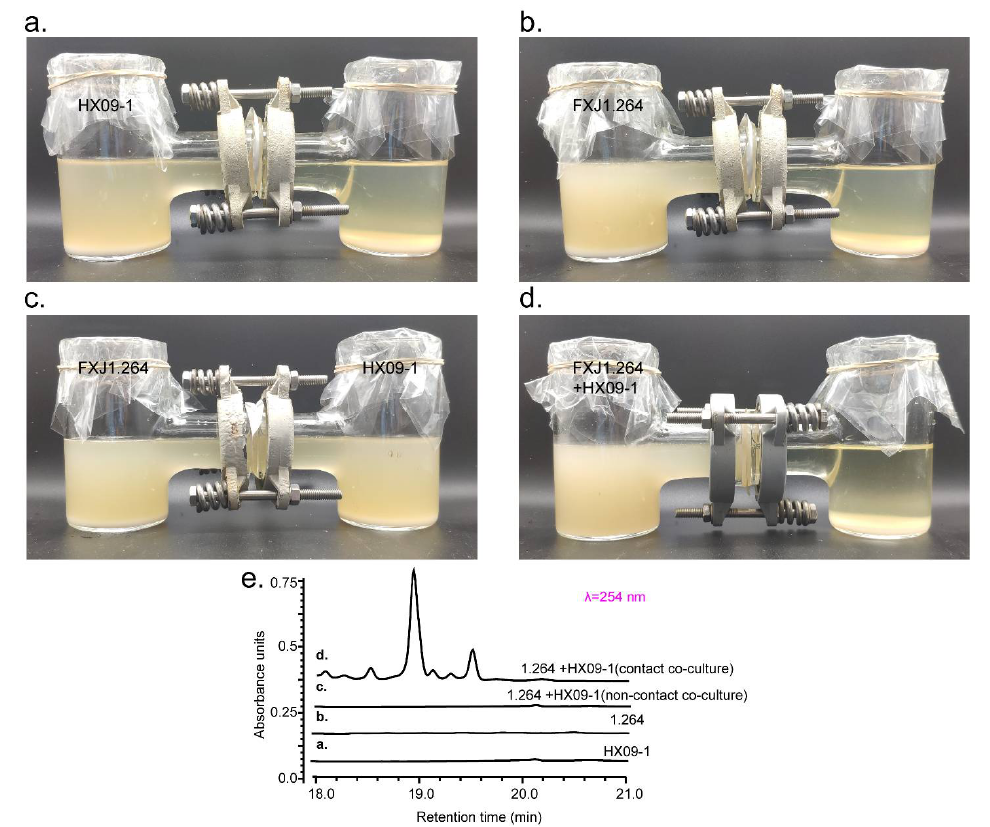
Figure 4. Contact and non-contact co-cultures of S . sp. FXJ1.264 and M . sp. HX09-1 and related HPLC profiling. ( a ) S . sp. FXJ1.264 was only inoculated in the left compartment; ( b ) M . sp. HX09-1 was only inoculated in the left compartment; ( c ) S . sp. FXJ1.264 and M . sp. HX09-1 were individually inoculated in the left and right compartment, respectively; ( d ) S . sp. FXJ1.264 and M . sp. HX09-1 were inoculated in the left compartment; ( e ) HPLC analysis of fermentation extracts from a to d .